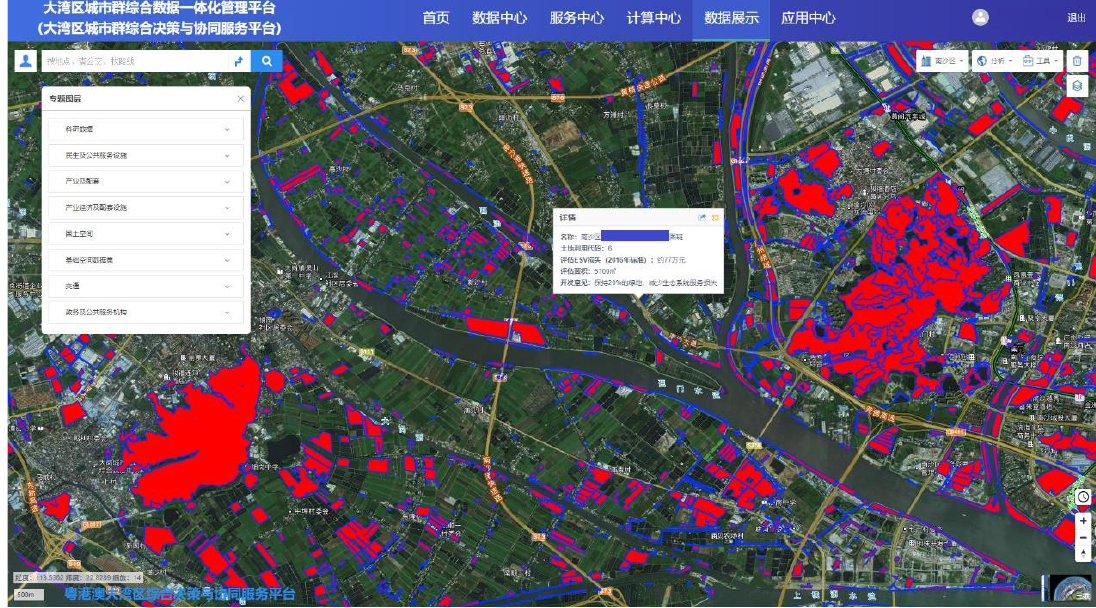
Figure 12. ESV coefficient application in GHM IDMP for evaluating ESV lost in land resource